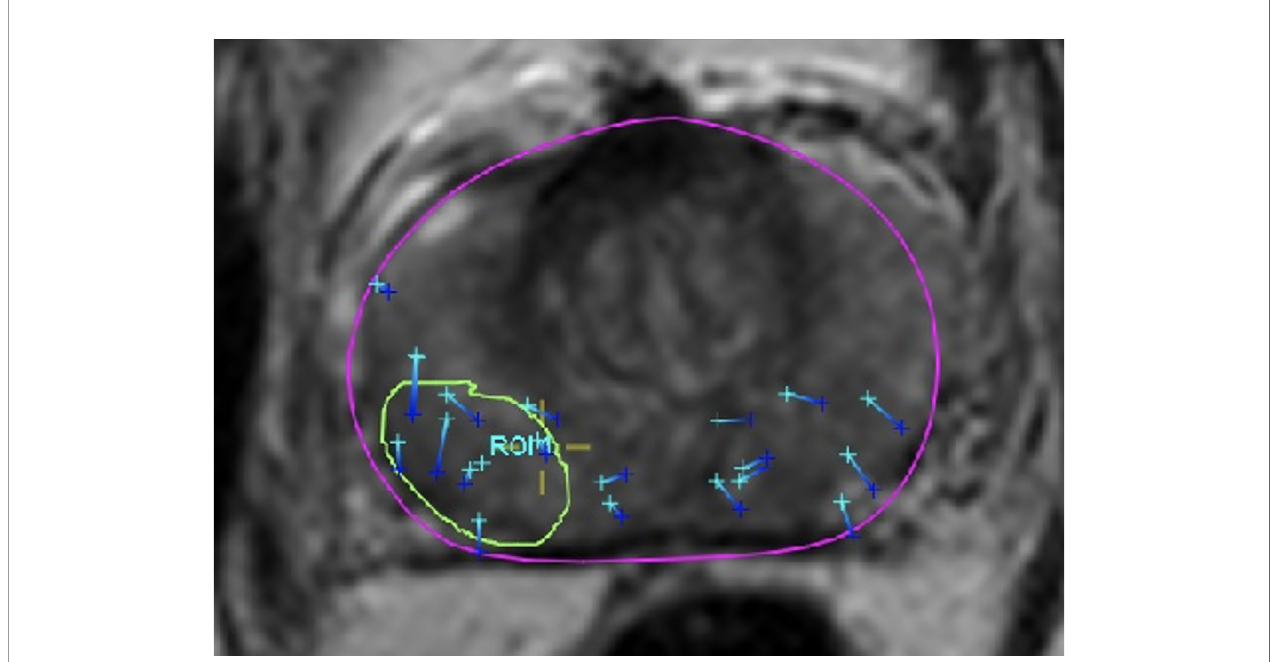
FIGURE 1 | Targeted and repeat whole-gland biopsies using the UroNav needle guidance system.